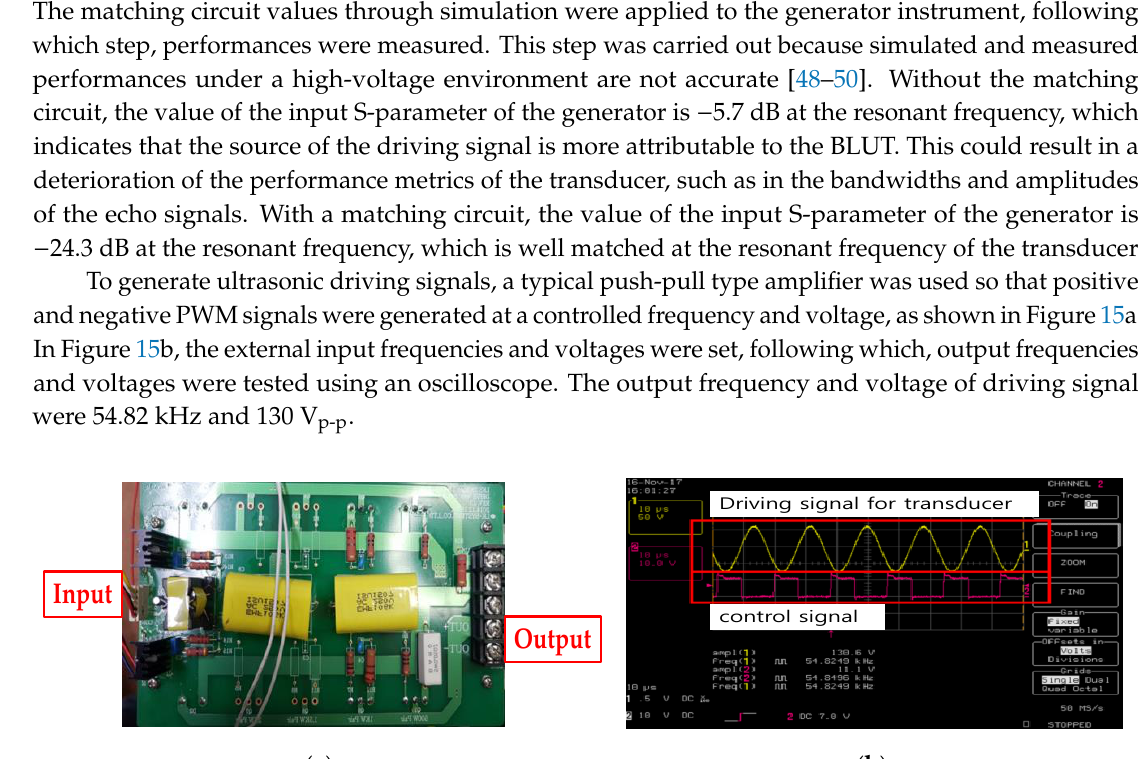
Figure 14. ( a ) Simulation model of the impedance matching circuit with the BLUT. ( b ) Equivalent circuit model of BLUT. S-parameter values vs. frequency ( c ) without a matching circuit and ( d ) with matching circuit.